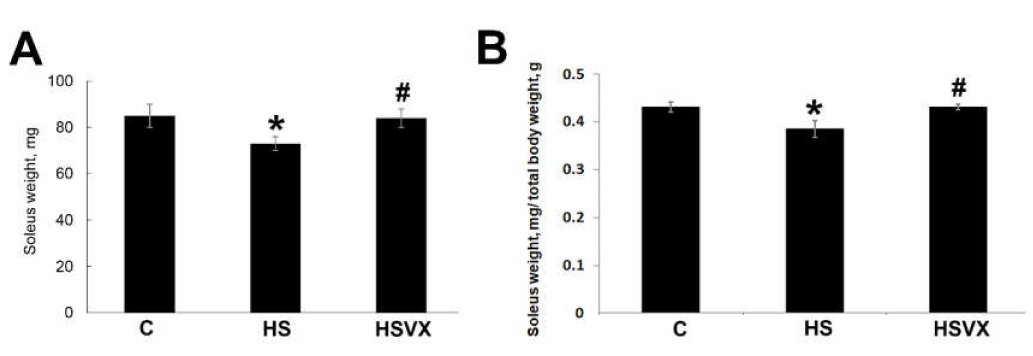
Figure 2. Absolute ( A ) and normalized ( B ) weight of soleus muscles of C, HS, and HSVX rats. n = 8. * indicates a significant di ff erence from the control, p < 0.05, # indicates a significant di ff erence from the HS, p <